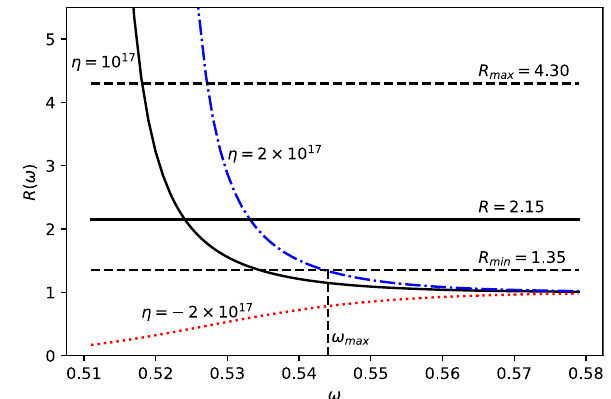
Fig. 7 R vs ω for fixed η,α 0 = 10 17 and energy E = E 12 (cid:2) 5 . 9 × 10 − 6 eV.Thesolidblack,thedash-dotblueanddottedredlinesrepresent cases 1) i) and ii) (positive and negative branch) respectively